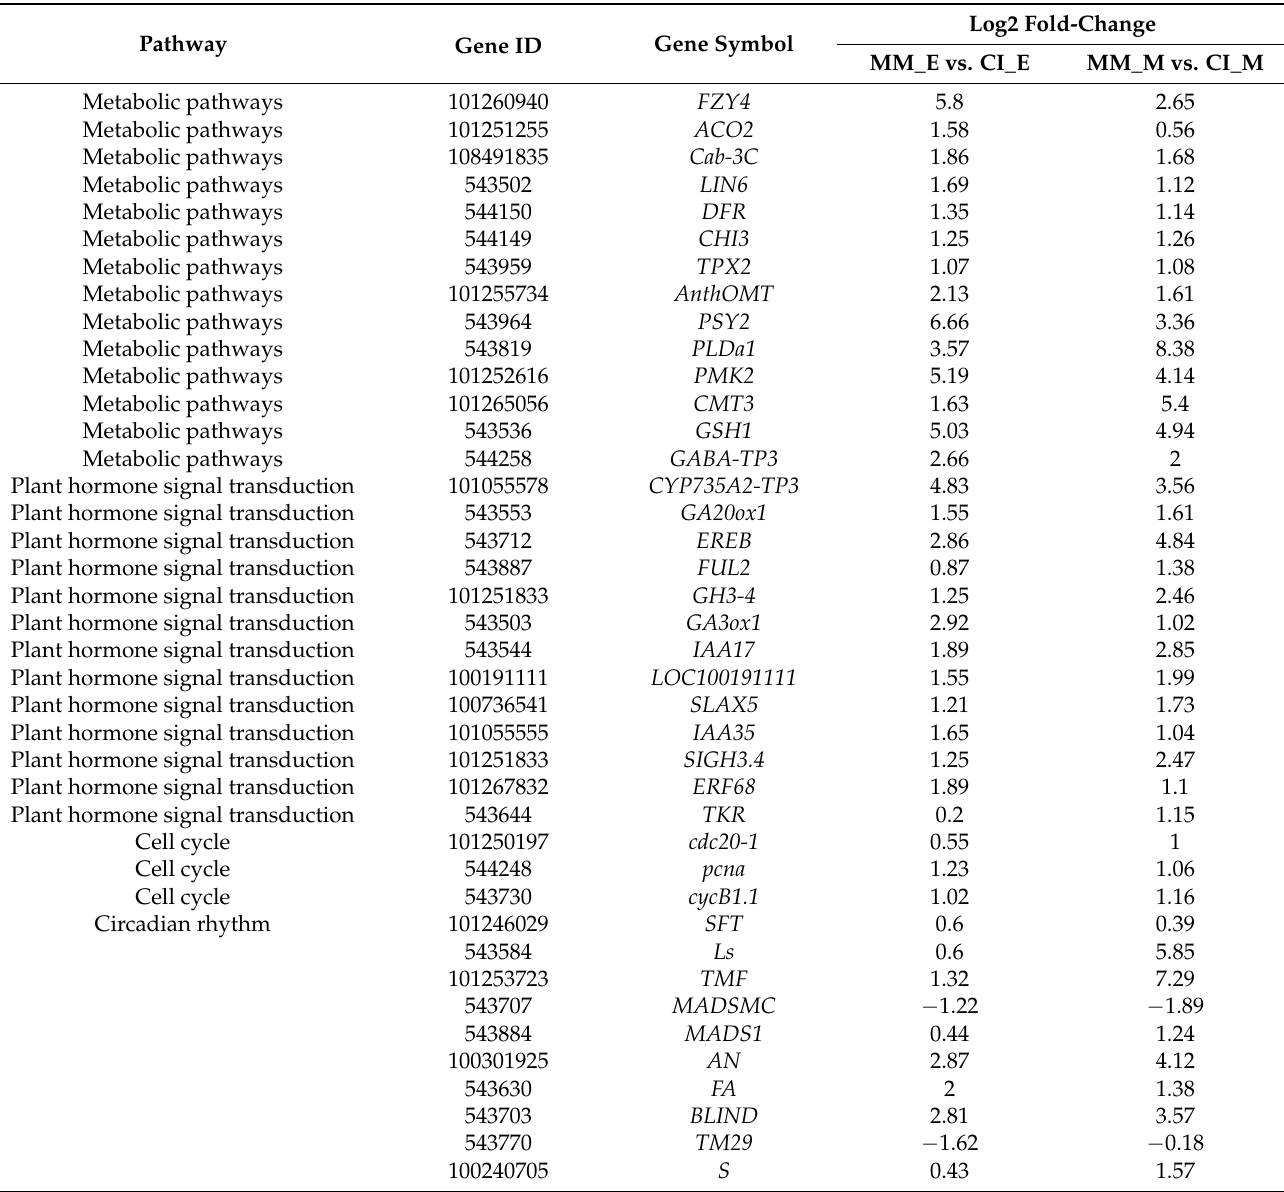
Table 2. Affect-related genes of tomato inflorescence